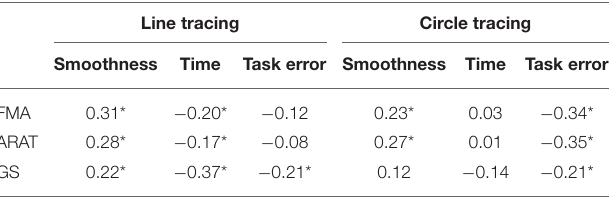
TABLE 4 | Results of the correlations between the clinical scales and the quantitative robotic measurements of both robotic assessment tasks (line tracing and circle